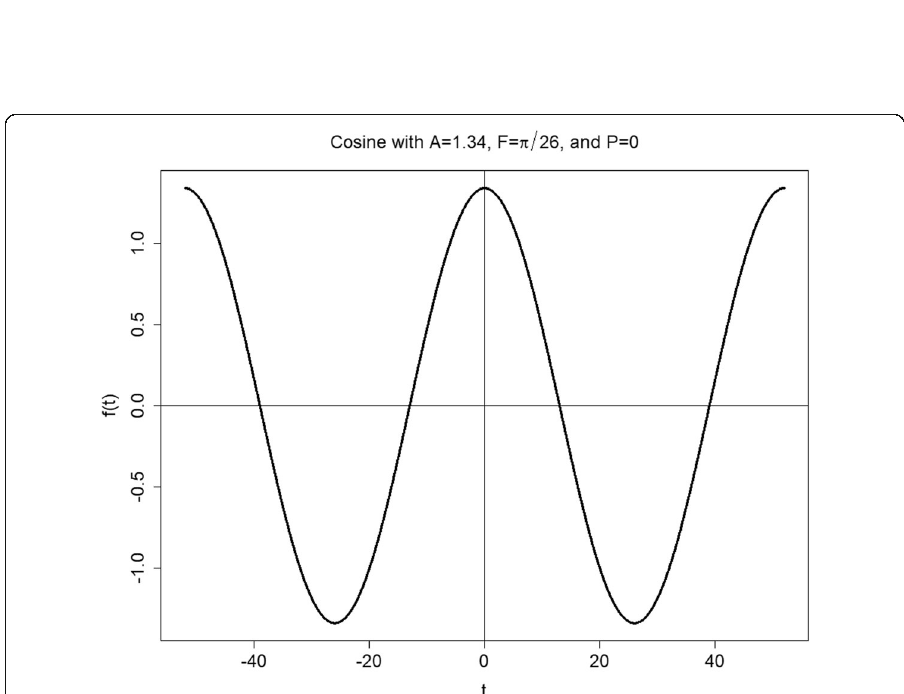
Fig. 13 Cosine function with amplitude 1.34 and period